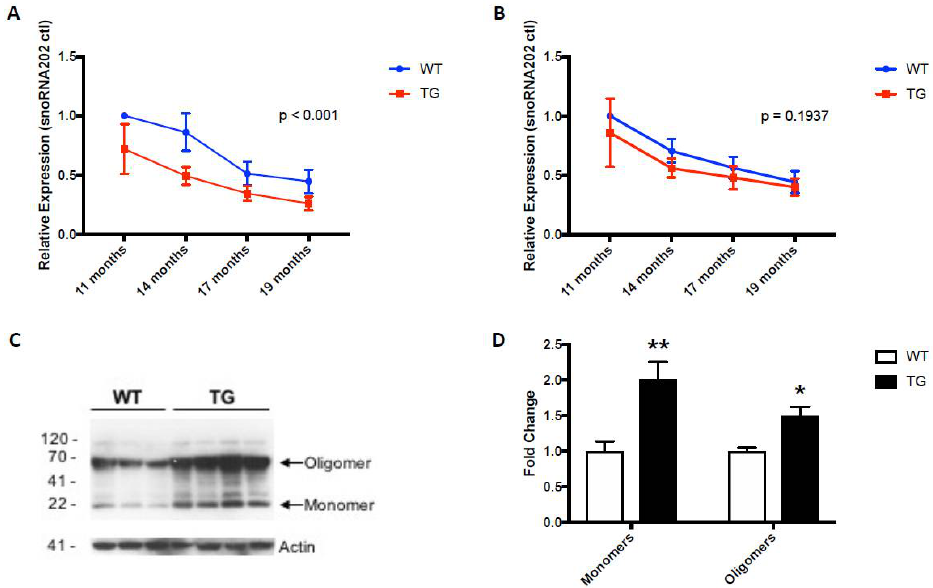
Figure 3. Expression patterns of miR-153 ( A ), miR-223 ( B ) and α -synuclein ( C , D ) in WT and GFAP.HMOX1 mouse blood. Blood serum was procured from WT and transgenic mice at 11, 14, 17 and 19 months of age, while RBCs were isolated from WT and transgenic mice at 19 months of age only. MiRNA expression levels were determined by RT-qPCR and analyzed using the Ct method relative to internal and endogenous controls. Western blot was used to measure -synuclein protein. For ( A , B ), n = 7–13; for ( C , D ), n = 7–8; * p < 0.05; ** p < 0.01. (From [64], with permission).